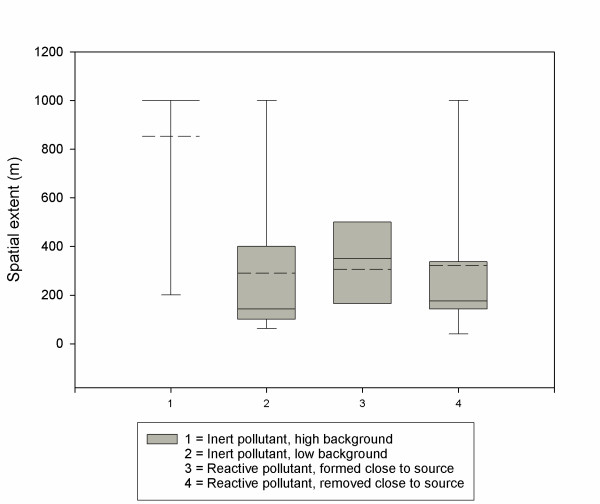
Spatial extent estimates from studies in meta-analysis, stratified by pollutant type. The dashed line represents the mean, the solid line the median, the box the 25th–75th percentile range, and the whiskers the 5th–95th percentage range.